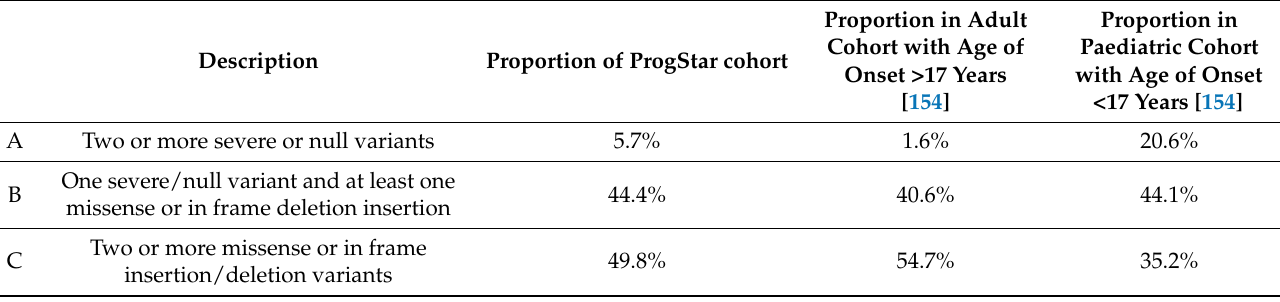
Table 3. The three genotype severity classifications described by Fujinami et al. and the proportion of patients with each of these severities